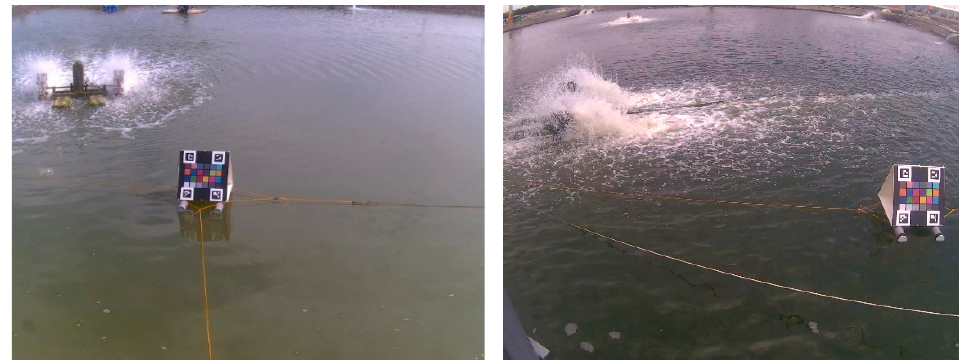
Figure 2. Two real scenes in which the color checkerboard is